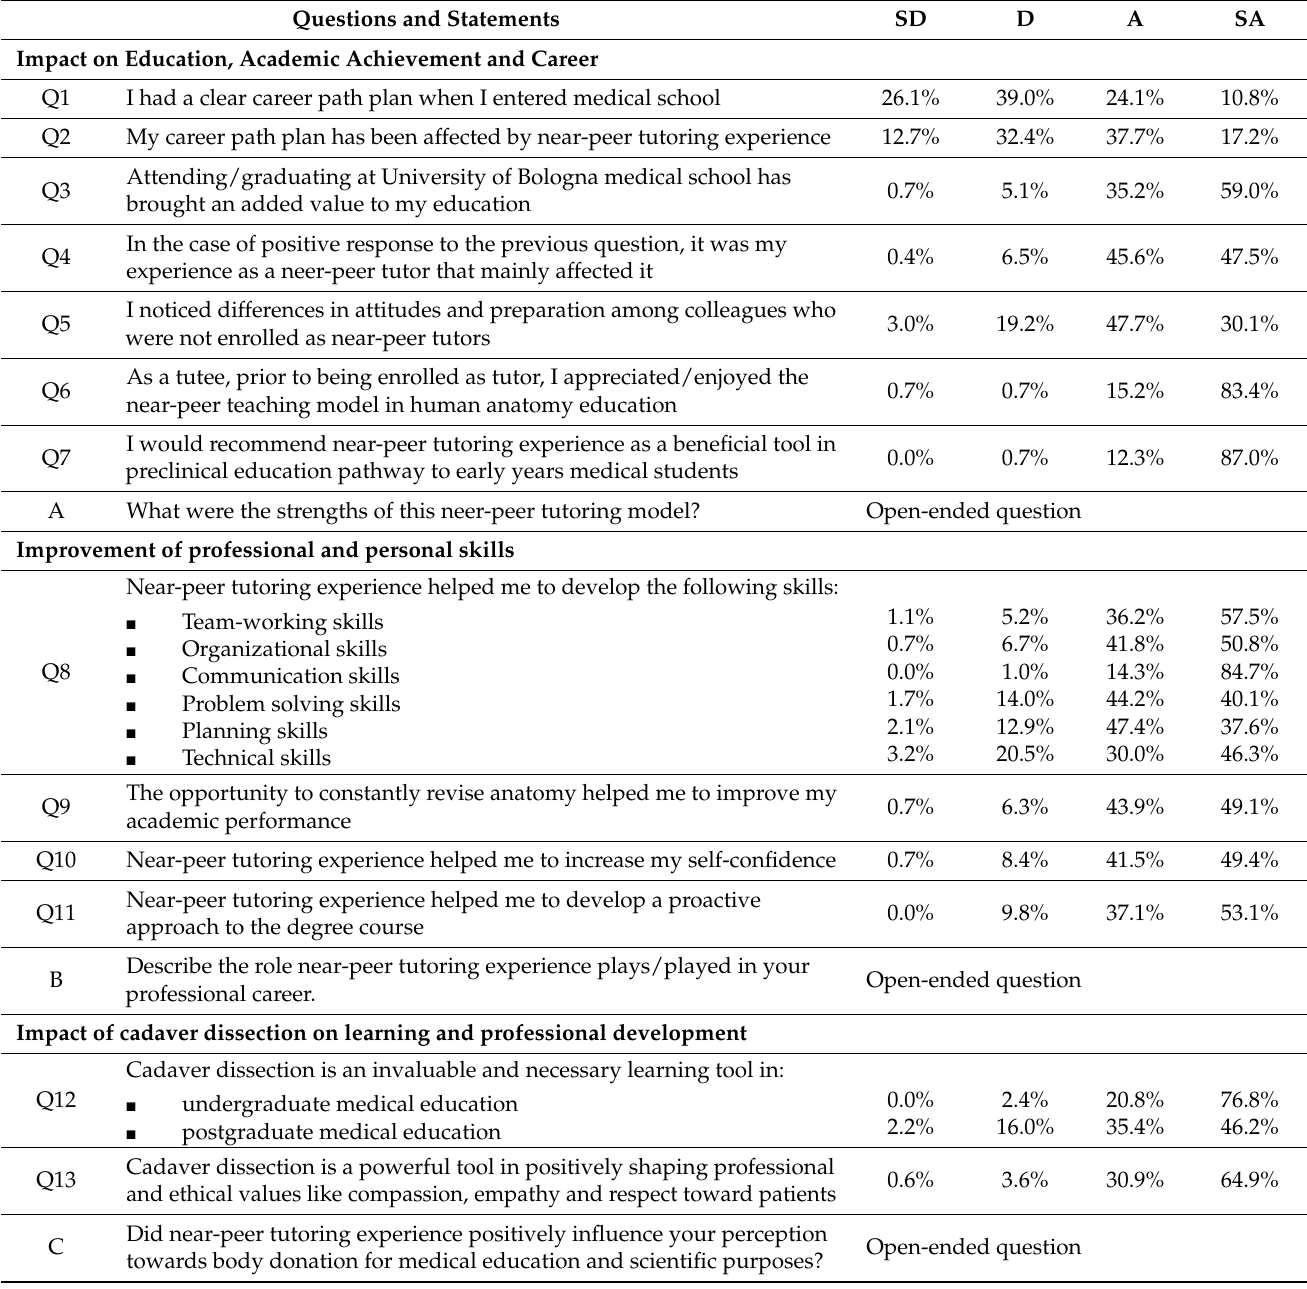
Table 1. Summary of survey questions and